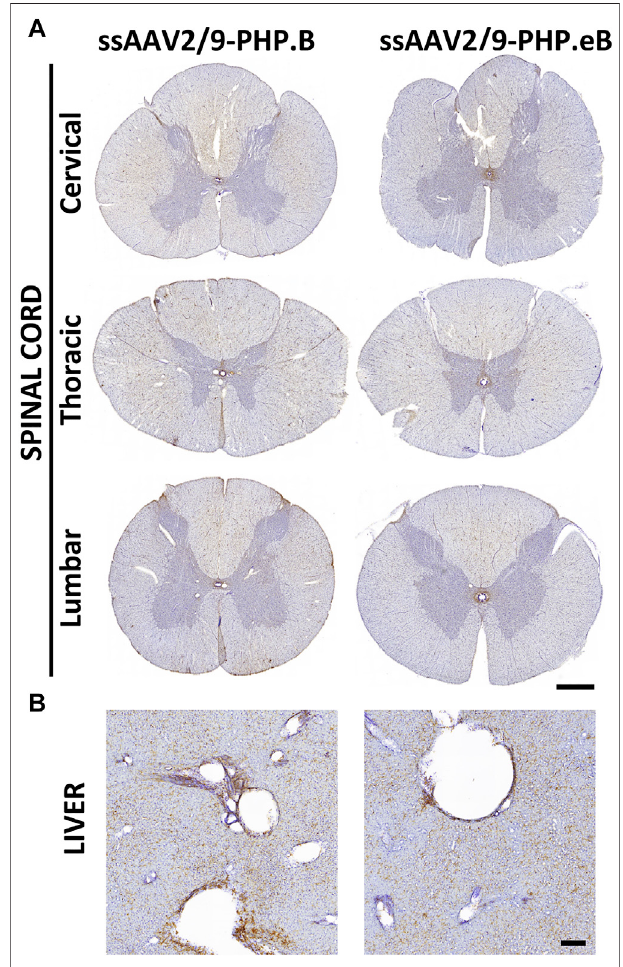
FIGURE6| Broadtransductionofthespinalcordandliverresultingfrom AAV-PHP. B and AAV-PHP. eB injections in non-human primates. (A) Representativeimageofspinalcord sectionsat threelevels (cervical,thoracic, lumbar) immunostained with EGFP in both injected monkeys. Scale bar: 1 mm. (B) Representative image of liver sections immunostained with a GFP antibody in both injected monkeys. Scale bar: 200 µm.